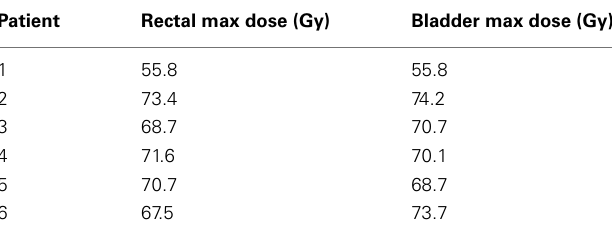
Table 2 | Summary of maximum rectal and bladder